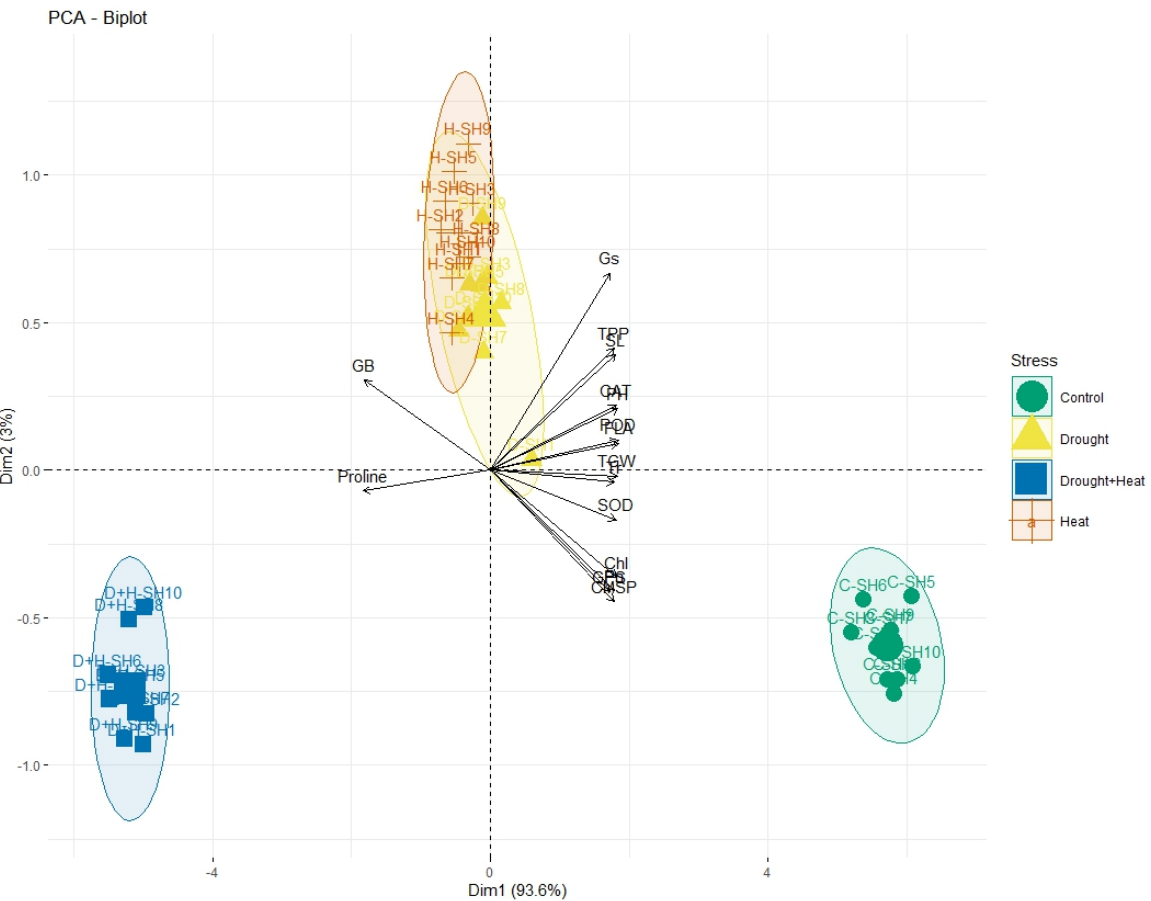
Figure 4. PCA plot showing the differential divergence of treatment interaction (genotypes × stress) circles with respect to proximity association of physiological, biochemical, and agronomic traits while extent of divergence of circles is directly associated with variation in the effect of interacting treatments. Pn; photosynthesis, Gs; stomatal conductance, Tr; transpiration rate, CMSP; cell membrane stability percentage, GB; glycine betaine, SOD; superoxide dismutase, POD; peroxidase, CAT; catalase, FLA; flag leaf area, PH; plant height, TPP; tiller per plant, SL; spike length, GPS; grains per spike, TGW; thousand grain weight.